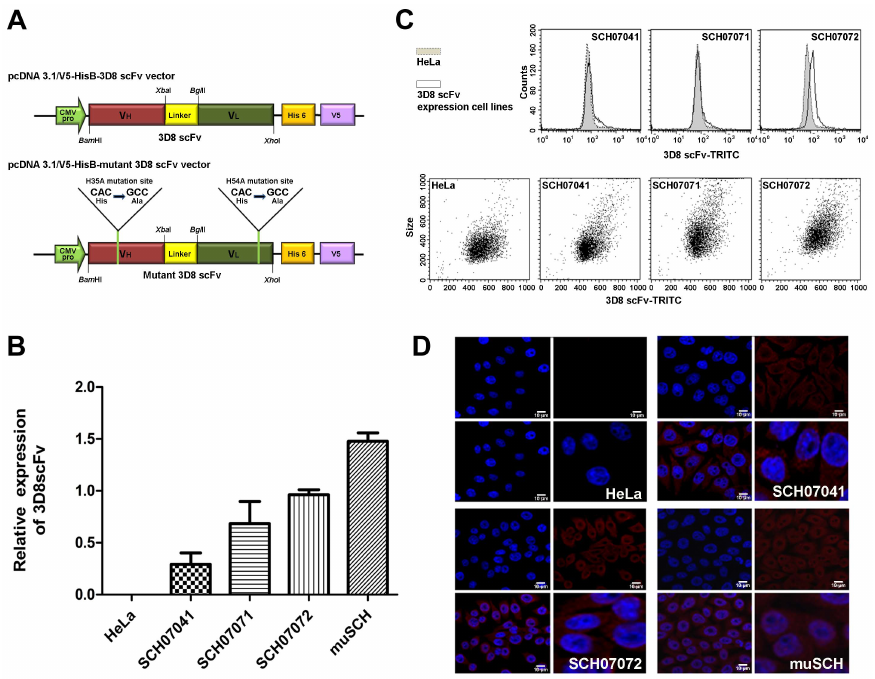
Figure 1. Construction of 3D8 scFv-expressing HeLa cells. A . Schematic diagrams of the plasmid constructs. Construction of the (a) pcDNA3.1/ V5-HisB-3D8 scFv vector and (b) pcDNA3.1/V5-HisB-mu3D8 scFv vector. Yellow line is the mutation site (His R Ala) B . 3D8 scFv expression levels were analyzed by quantitative real-time polymerase chain reaction (PCR) in transgenic cell lines. The relative concentrations of 3D8 scFv were calculated after normalization to the GAPDH gene using the delta delta C T method. Data bars represent mean 6 standard error. The expression levels of each cell line were compared to SCH07072. C . Identification of three 3D8 scFv cell lines (SCH07041, SCH07071, and SCH07072) by flow cytometry. Transgenic and wild-type HeLa cells were stained with 3D8 scFv Ab and TRITC-anti-rabbit Ig for flow cytometry. D . Localization of 3D8 scFv in transgenic and wild-type HeLa cells by immunocytochemistry. Nuclei were detected by DAPI staining (blue). 3D8 scFv expression was monitored by immunofluorescence using a polyclonal anti-3D8 scFv antibody that was visualized with TRITC (Rhodamine Red). 3D8 scFv proteins were localized in both the cytosol and nucleus of SCH07072 and muSCH cells.